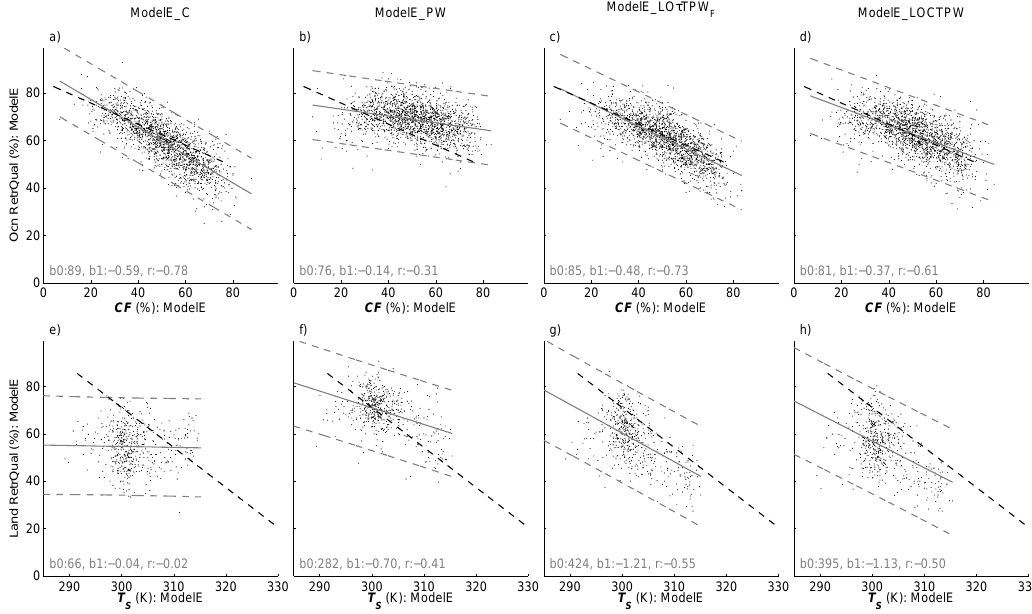
Fig. 11. Approximated retrieval quality as function of CF over the ocean (top) and T S over land (bottom) for four representative categoriza- tions. Grey dashed lines show the 95% prediction intervals. Black dashed lines show the corresponding linear fits from TES observations in Fig. 4a and